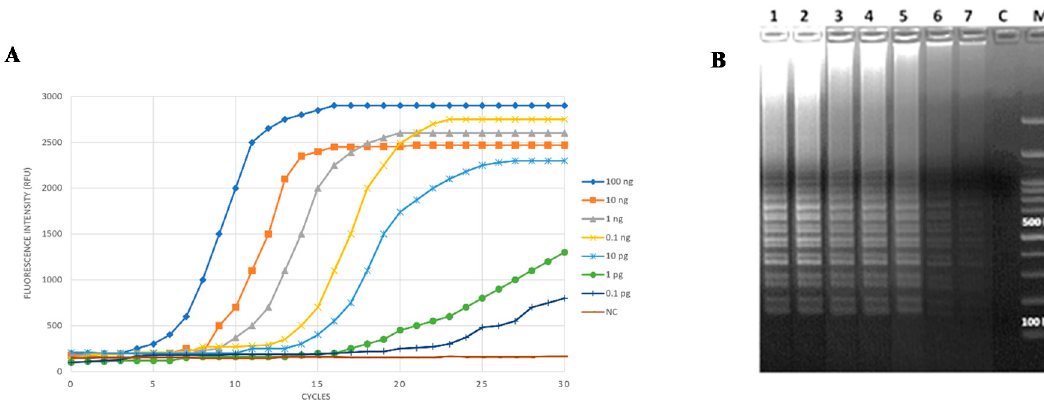
Figure 2. Determination of the analytical sensitivity of the LAMP assay for C ff detection. Isothermal amplifications were carried out on tenfold diluted test samples of C ff ICMP 2584 T DNA (from 100 ng to 100 fg per 25 µ L reaction). Data assessment was based on ( A ) real-time fluorescence monitoring and ( B ) 2% agarose gel electrophoresis analysis of the LAMP products. ( A ) NC = negative control. 1 cycle = 1 min reaction. ( B ) Lanes 1–7: 100 ng, 10 ng, 1 ng, 0.1 ng, 10 pg, 1 pg, and 0.1 pg of genomic DNA / reaction, respectively; M - Gene Ruler 100 pb Plus DNA Ladder; C = negative control.